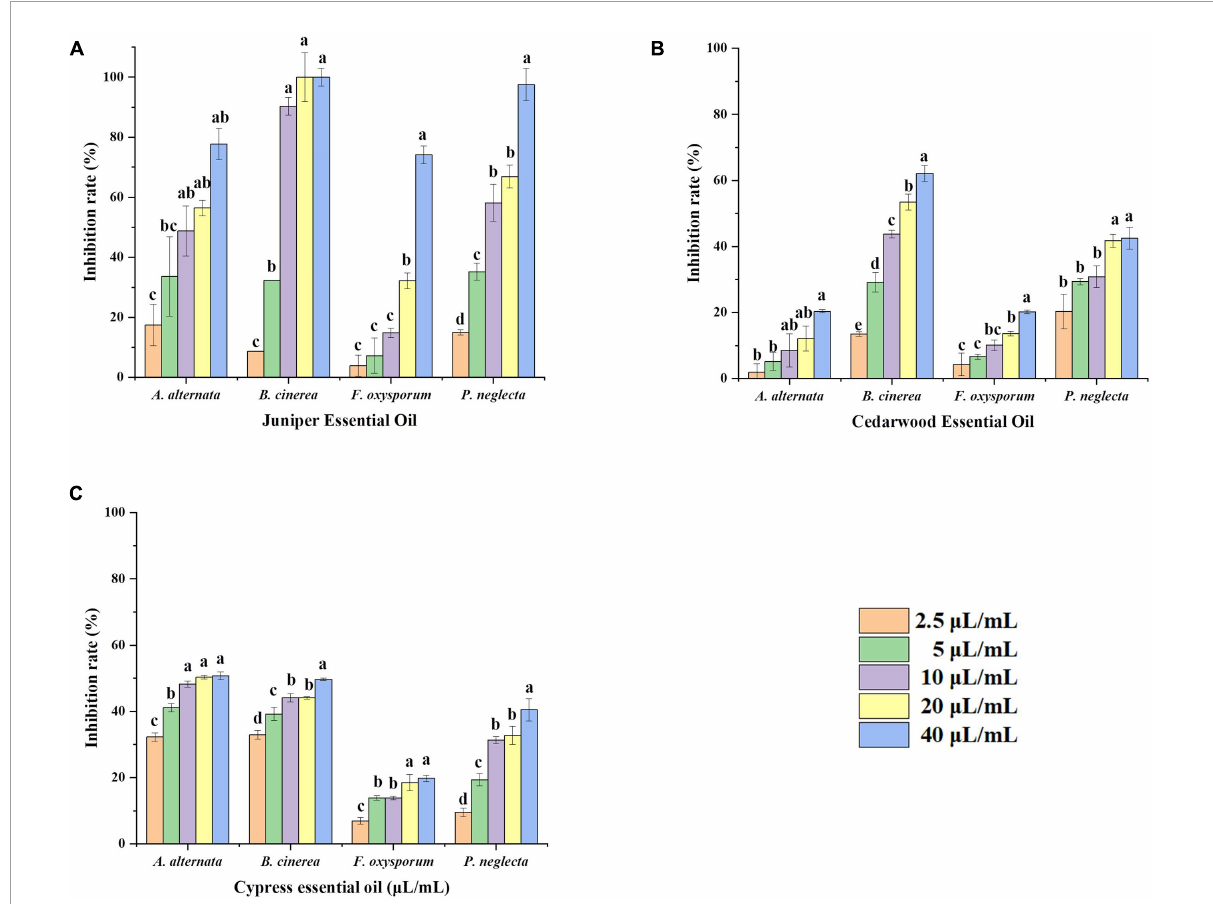
FIGURE1 Effect of different concentrations of plant essential oils on the rate of inhibition of mycelial growth of four pathogenic fungi. Mycelial growth inhibition rates were calculated for JEO (A) CWEO (B) , and CPEO (C) after treatment with different concentrations (0, 2.5, 5, 10, 20, and 40 µ L/mL) of plant essential oils and incubated for 5 d at 25 ◦ C. Bars represent the standard error of the mean ( n = 3). Letters (a, b, c, d) indicate statistically significant differences between concentrations according to Duncan’s multiple range test ( P < 0.05). CPEO, cypress essential oil; CWEO, cedar wood essential oil; JEO, juniper essential